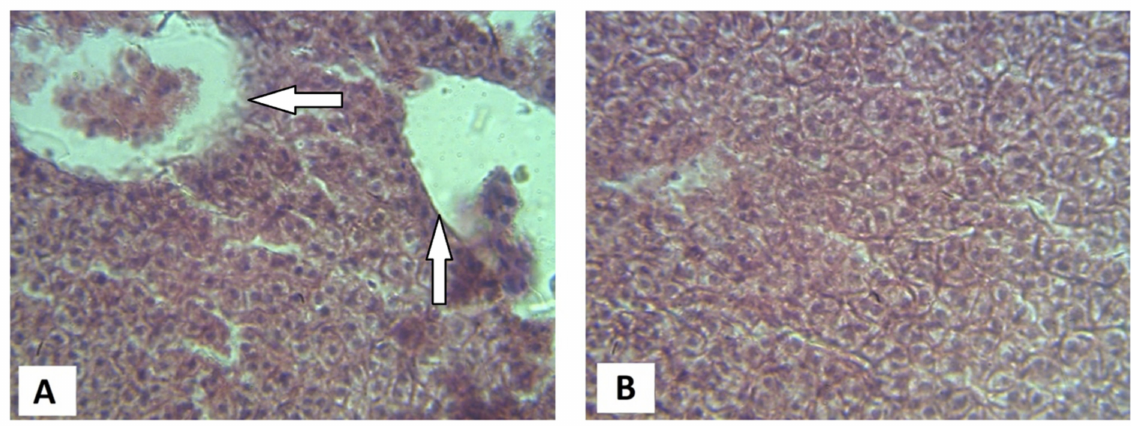
Figure 1. Microsection of the intestine of African catfish C. gariepinus fed inclusion of ( A ) raw J. curcas kernel; ( B ) and 72 h socked J. curcas kernel (arrows shows sloughed epithelial linings).